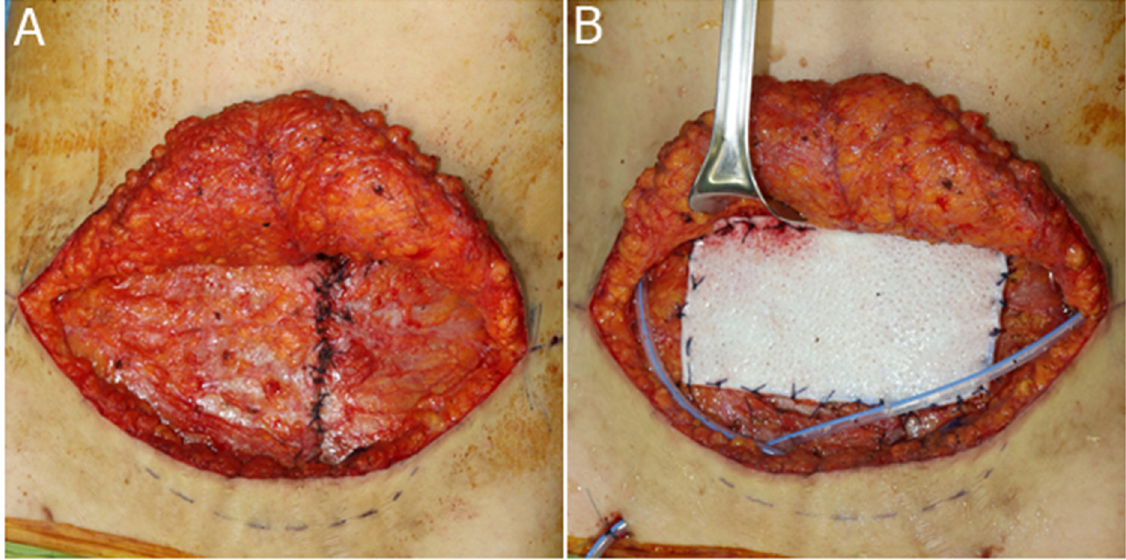
Figure 3. Surgical techniques used for the correction of abdominal bulging. ( A ) Plication of the abdominal fascia. ( B ) Onlay graft of acellular dermal matrix.